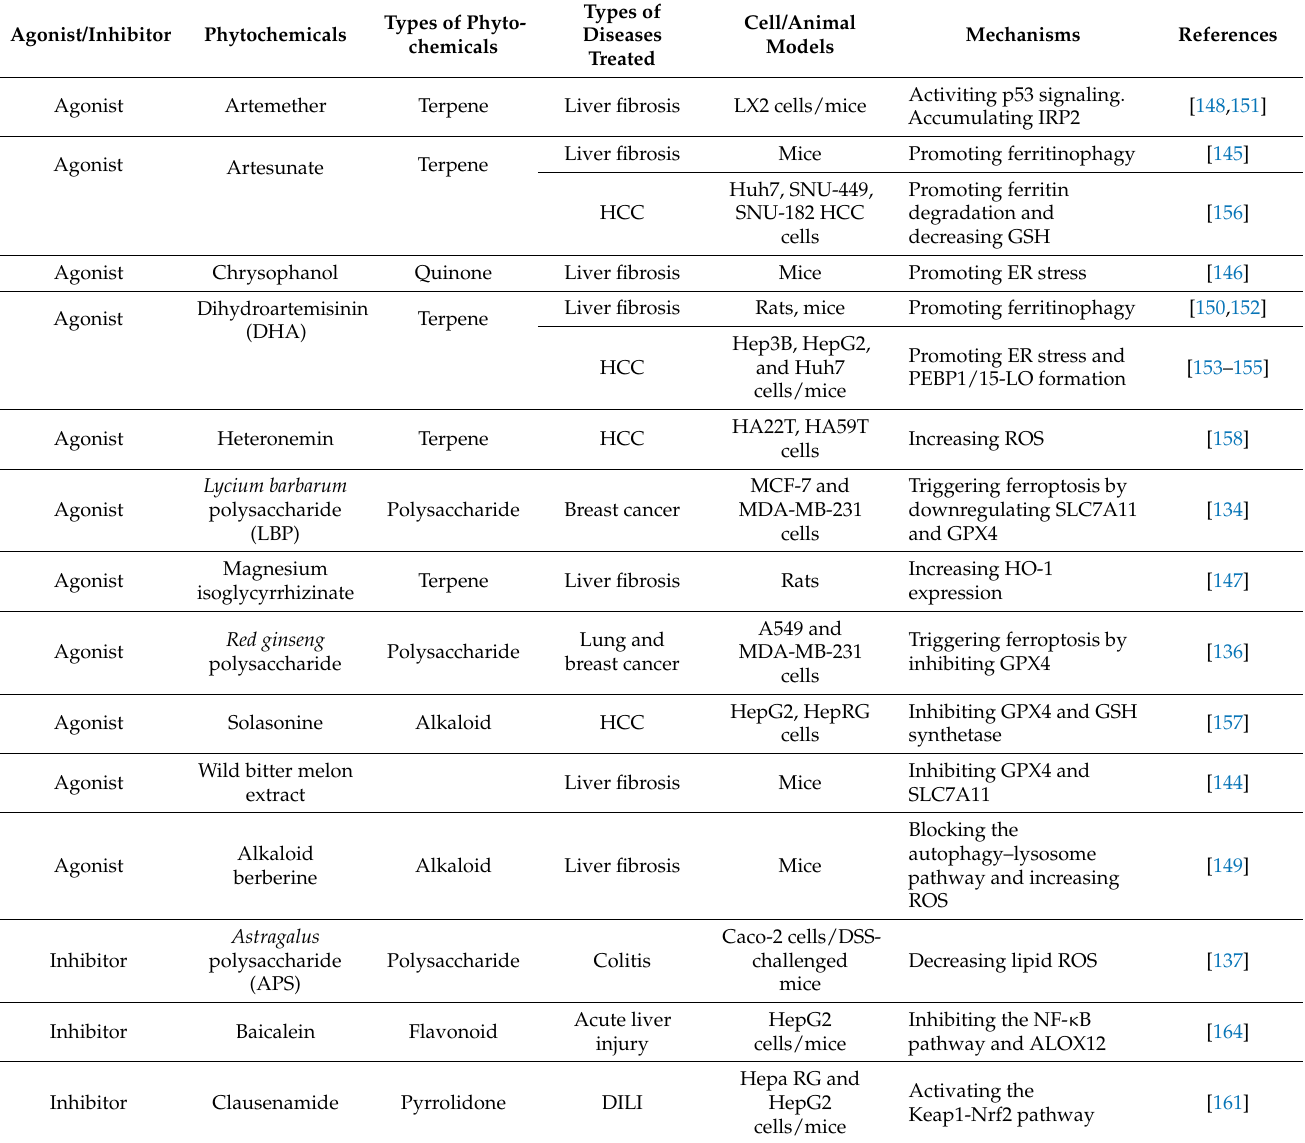
Table 2. Phytochemicals in ferroptotic